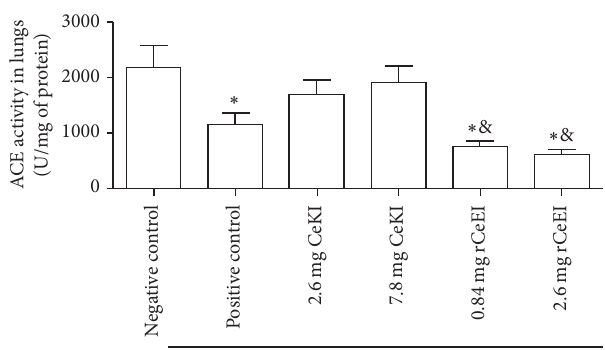
Figure 3: ACE activity in lungs. Rats were pretreated intravenously with buffer (negative or positive controls), CeKI (7.8 or 2.6 mg), or rCeEI (2.6 or 0.84 mg). After 20 min, they received 75 𝜇 g of LPS/animal (positive control and CeKI and rCeEI groups) or buffer (negative control) injected via the trachea directly into their lungs. Six hours later, lungs were extracted and homogenized. Samples of lung (5 𝜇 L) were maintained in 50mM Tris buffer at pH 7.4 containing 50mM NaCl for 5 min at 37 ∘ C before the addition of the substrate Abz-F-R-K(Dnp)-P-OH (10 𝜇 M) in a final volume of 200 𝜇 L. Fluorescence changes were monitored continuously for 30 minat 𝜆 ex = 320 nm and 𝜆 em = 420 nm.Theslopeof thegenerated fluorescence signal was converted into micromoles of substrate hydrolyzed per minute based on a calibration curve obtained from the complete hydrolysis of peptide and adjusted for total protein quantity. ∗ Significant difference compared to negative control (𝜌 < 0.05) . & Significant difference compared to CeKI-treated groups (𝜌 < 0.05)